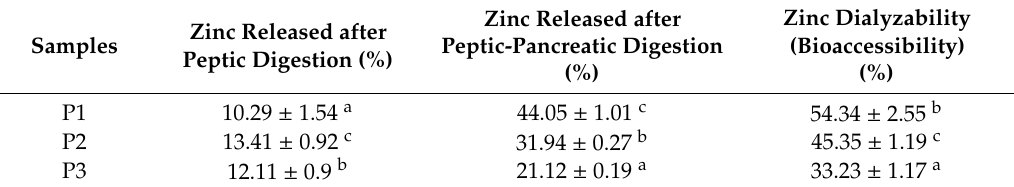
Table 4. Zinc release and dialyzability of peptide-zinc complexes after simulated gastric and gastrointestinal digestion of three molecular weight peptide